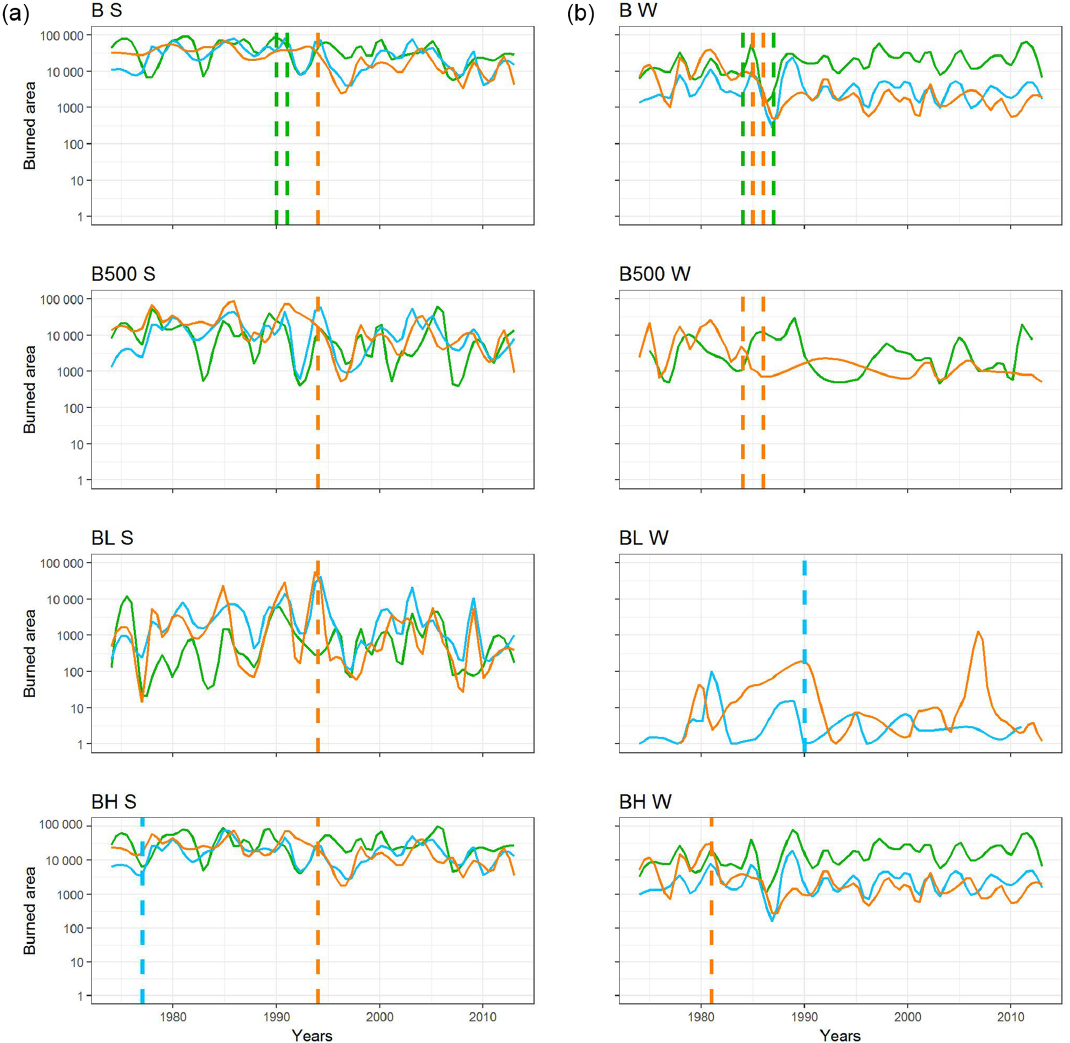
Figure 3. Detected change points and temporal evolution of burned area features (log scale) for the period 1974–2013 in the three regions examined: Northwest is indicated by the green line, Hinterland by the light blue line and the Mediterranean by the orange line. Column (a) refers to the summer season, while (b) is winter. Dashed vertical lines represent probable change points. See Sect. 2.1 for acronyms and description of fire